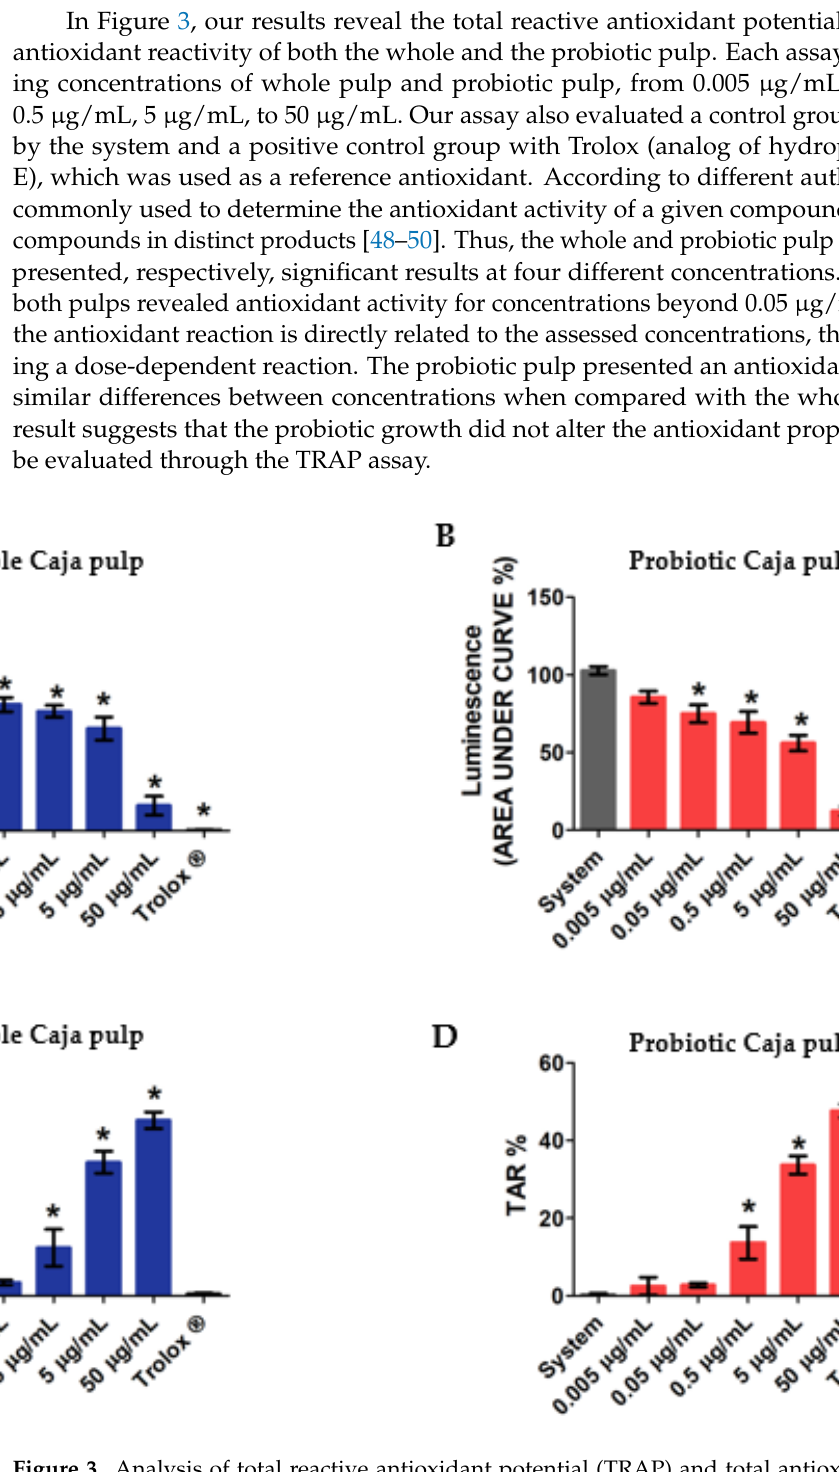
Figure 3. Analysis of total reactive antioxidant potential (TRAP) and total antioxidant reactivity (TAR) of the whole and probiotic caja pulps: ( A ) TRAP whole caja pulp; ( B ) TRAP probiotic caja pulp; ( C ) TAR whole caja pulp; ( D ) TAR probiotic caja pulp. The mean of three replicates ( n = 3) and the values are expressed as the mean ± SEM. * p < 0.05 value describes a comparison through ANOVA. Tukey test was